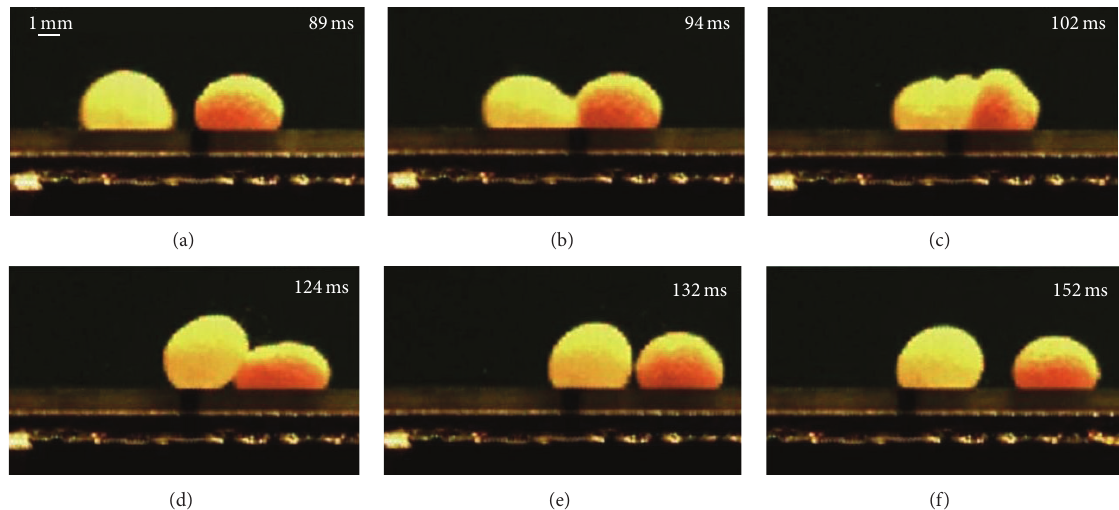
Figure 2: Sequence of images illustrating the quasielastic collision between lycopodium coated liquid marbles. Scale bar is 1mm.